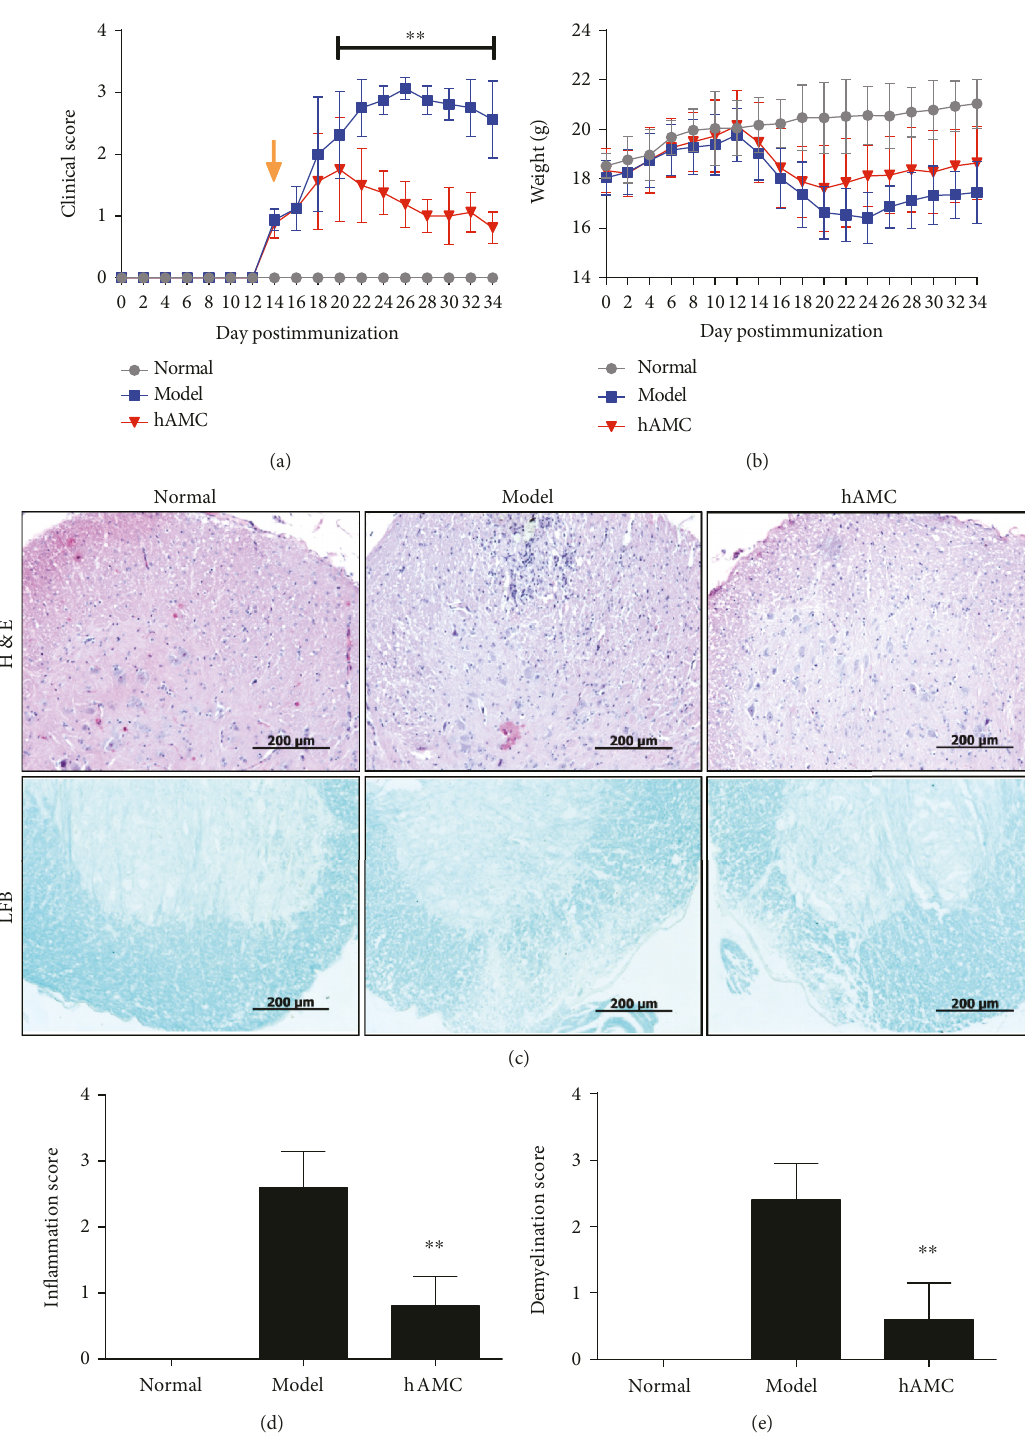
Figure 2: hAMC ameliorates the clinical symptoms and improves CNS pathology of EAE mice. (a) Time course changes of mean clinical score in the mice from respective group. Arrow shows the starting point of hAMC treatment. (b) Time course changes of body weight in the mice from respective group. (c) Representative histological fi nding of spinal cords from each group. Tissue sections from the spinal cords were stained with H&E or LFB, respectively. Scale bars, 200 μ m. (d) Histological in fl ammation score in each group. (e) Demyelination score in each group. Results are shown as mean ± SD. n = 8 mice per group. For pathological analysis, n = 5 sections per animal, eight mice in each group. ∗∗ P < 0 01 , compared to model